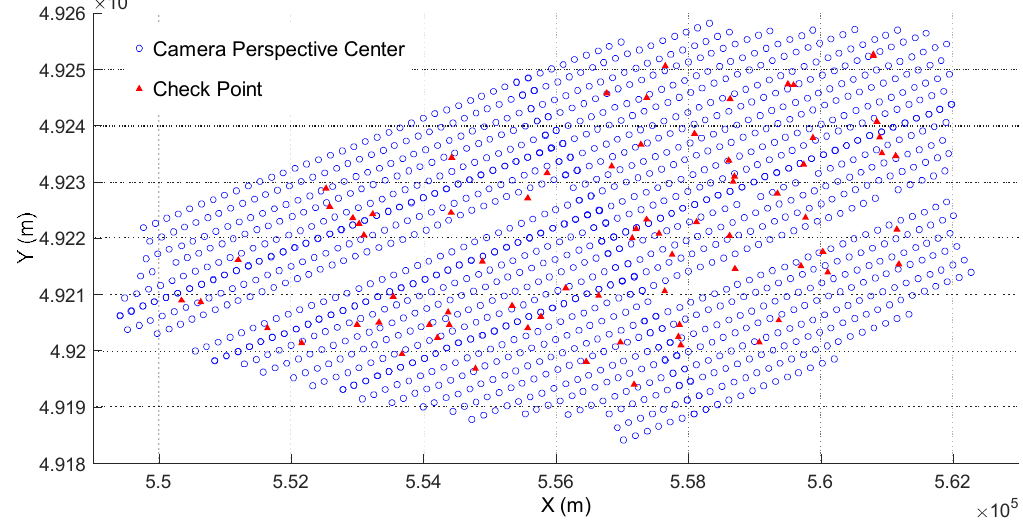
Figure 8. Distribution of the check points and camera perspective centers of data I. Table 3. Error statistics before and after the iterative calculations of the registration (Unit: m).